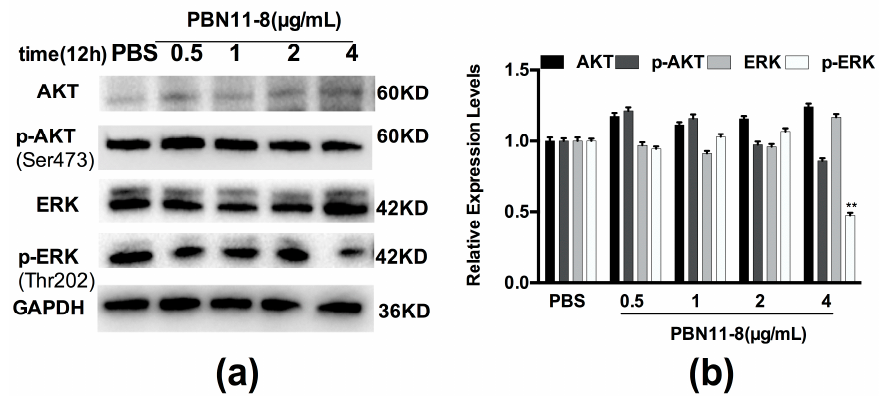
Figure 6. PBN11-8 suppressed extracellular regulated protein kinases (ERK) in BEL-7402 cells. ( a ) BEL-7402 cells were treated with (and without) 0.5, 1, 2, and 4.0 µg/mL PBN11-8. After incubation for 12 h, cells were collected and the cell protein was isolated for Western blot analysis of AKT, p-AKT, ERK, and p-ERK to be performed. Cells treated with PBS were used as negative control and the expression of GAPDH was used as an internal reference. ( b ) The quantitative evaluation of each lane of BEL-7402 cells in the Western blot was measured by Image J and normalized to untreated cells. Data represent the mean ± SD of three independent experiments. ** p < 0.01 vs. control.